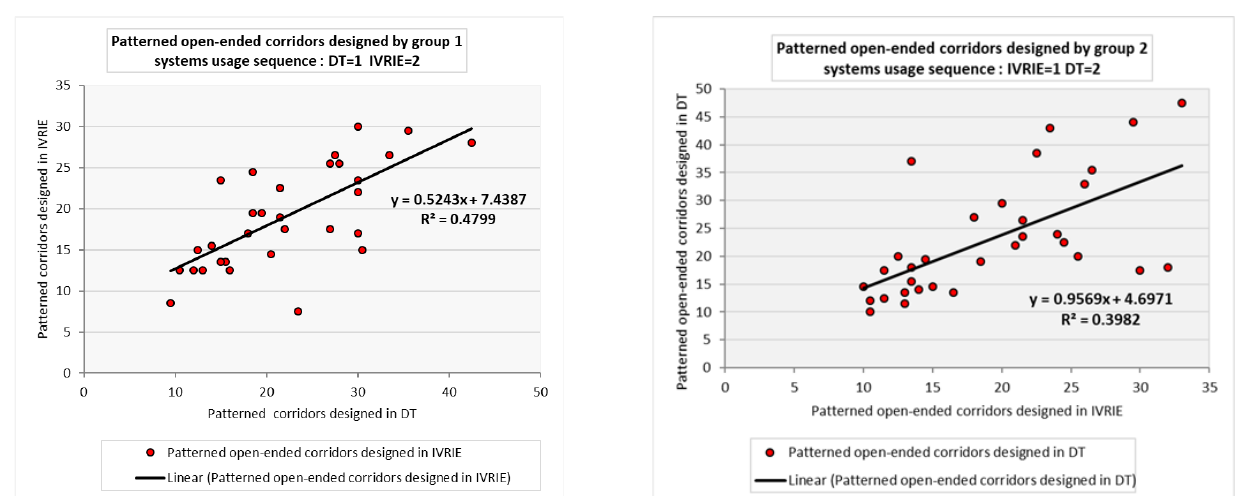
Figure 13. Linear regressions for patterned, open-ended corridors designed in IVRIE and the DT system by both groups of participants.